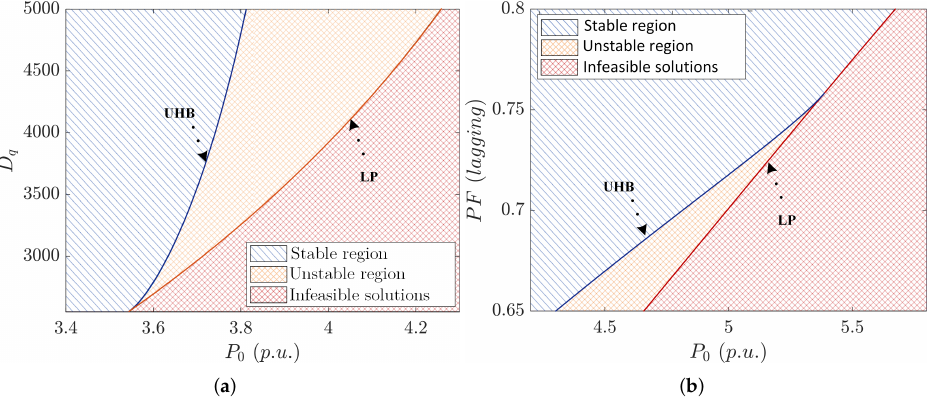
Figure 18. Stability region when varying: ( a ) The control gain D q . ( b ) The power factor PF